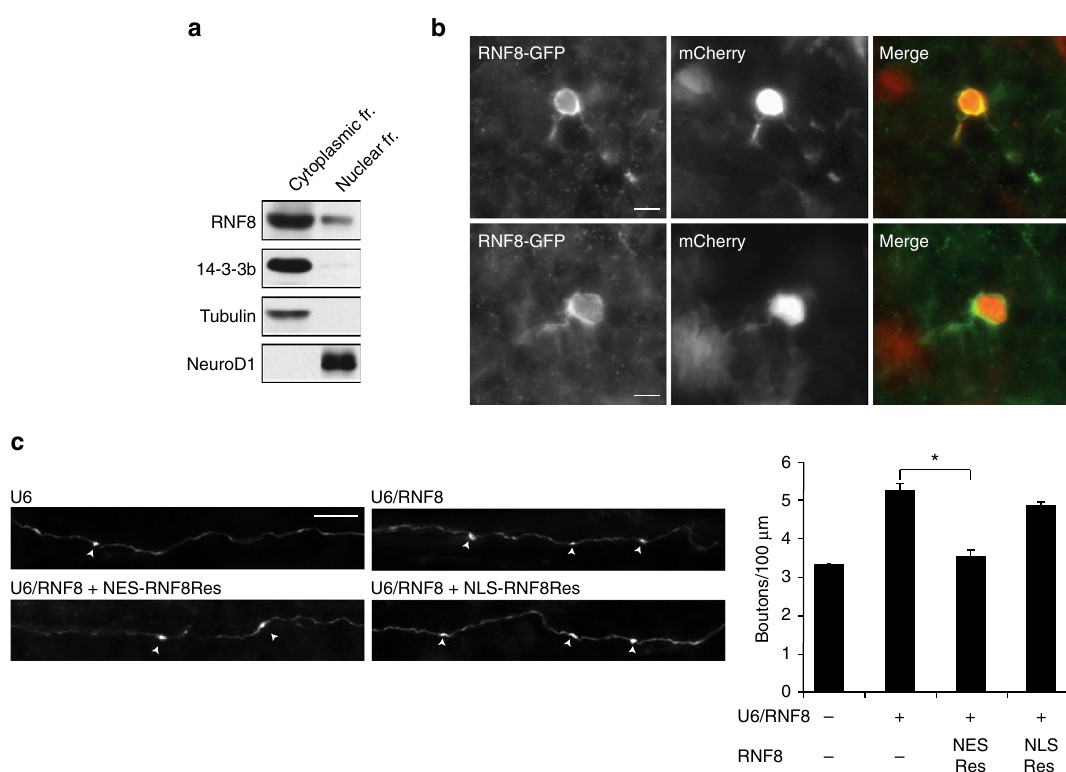
Fig. 3 RNF8 operates in the cytoplasm to suppress presynaptic differentiation in vivo. a Immunoblotting analyses of fractionated lysates of P8 rat cerebellum revealed abundant endogenous RNF8 in the cytoplasmic fraction in the cerebellum. b P4 rat pups were electroporated with an expression plasmid encoding an RNF8 – GFP fusion protein together with a mCherry expression plasmid. After 8 days, rat pups were sacri fi ced and the cerebellum was subjected to immunohistochemistry using GFP and DsRed (mCherry) antibodies. RNF8 localizes predominantly in the cytoplasm. c P4 rat pups were electroporated with the control U6 plasmid or RNF8 RNAi plasmid together with an expression plasmid encoding NES(nuclear export signal)-RNF8Res fusion protein, NLS(nuclear localization signal)-RNF8Res fusion protein or the control vector and with the GFP expression plasmid and analyzed as in Fig. 1a. Expression of NES-RNF8Res, but not NLS-RNF8Res, reversed the RNF8 RNAi-induced phenotype of increased number of parallel fi ber presynaptic boutons in the cerebellum in vivo (* p < 0.05, ANOVA followed by Fisher ’ s PLSD post hoc test, n = 3 – 4 rats). Scale bars = 10 μ control littermate mice (control: 13.98 ± 0.469 synapses/100 μ m 2 ; RNF8 cKO: 20.59 ± 1.843 synapses/100 μ m 2 ; n = 3 mice; mean ± s.e.m.; p = 0.025, t test) (Fig. 1d). Notably, parallel fi ber/